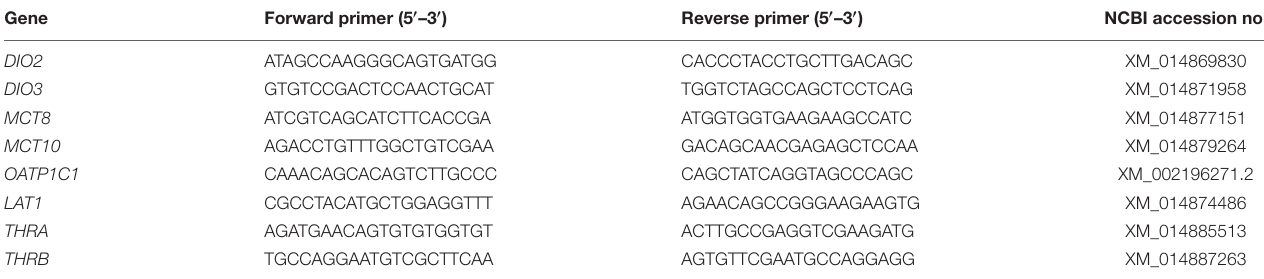
TABLE 1 | Primers for cloning of partial sequences of thyroid hormone regulators in starling. Gene Forward primer (5 (cid:48) –3 (cid:48) ) Reverse primer (5 (cid:48) –3 (cid:48) ) NCBI accession